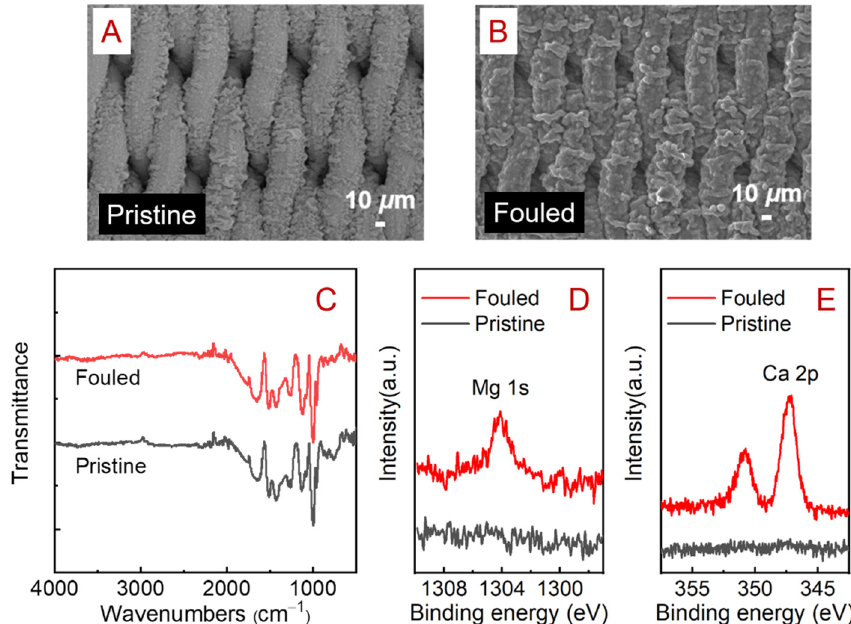
Figure 5. SEM views of the ( A ) pristine and ( B ) fouled SSM/PPY(AOT) membranes operated in the M RO mode in the antifouling filtration experiments with foulant solution II. ( C ) FTIR spectra and ( D , E ) XPS analyses of the pristine and fouled membranes.